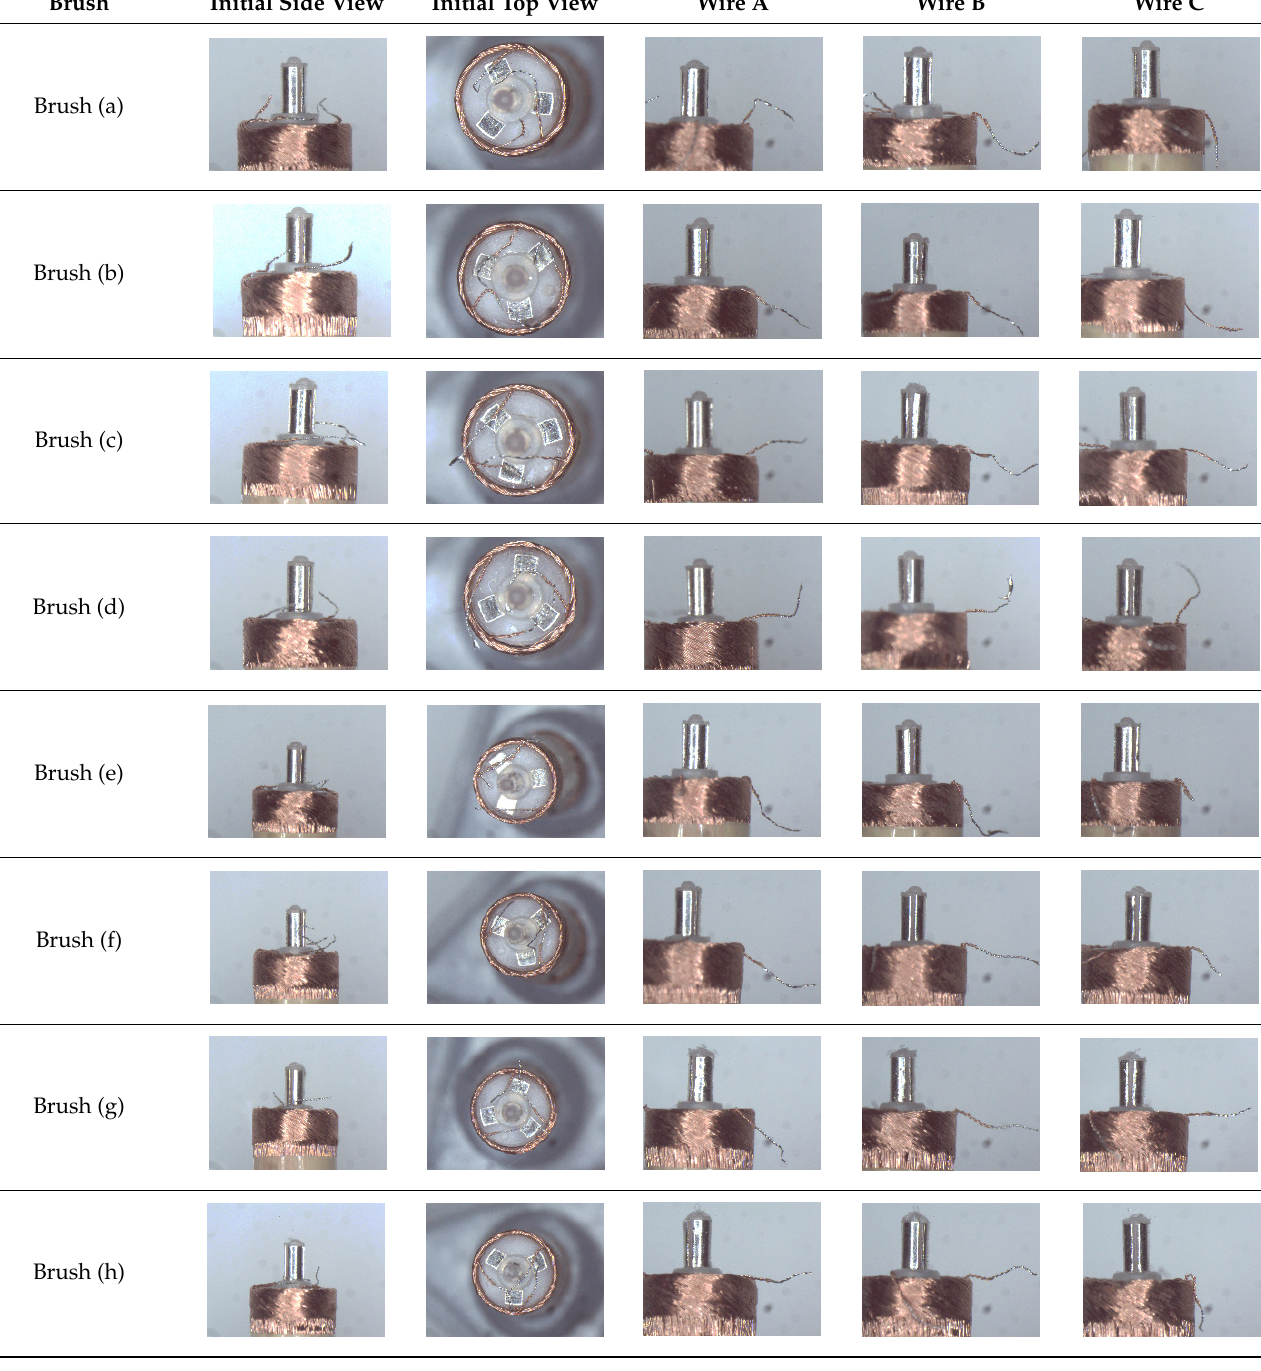
Table 6. Brushing results using the micro-manipulators listed in Table 4 made by nylon and bristle material.